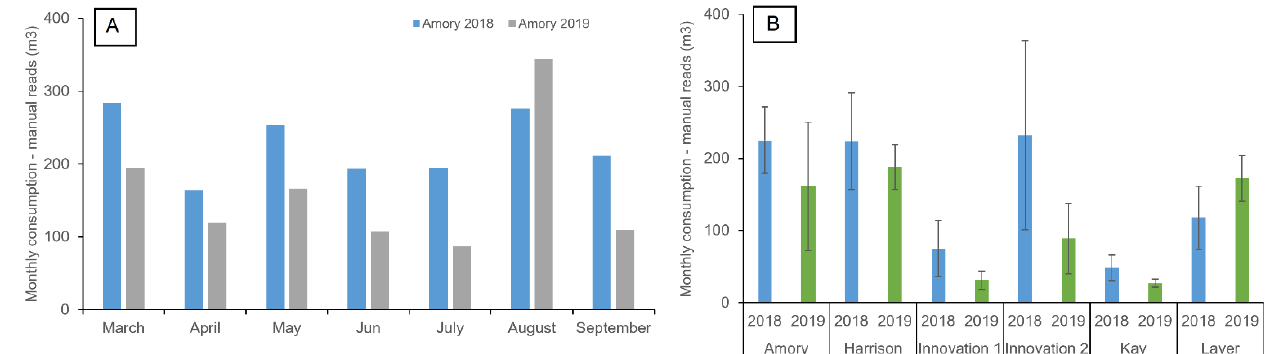
Figure 5. Comparison of estimated monthly consumption based on ( A ) manual monthly readings the Amory building between March–September 2018 (prior to ULFT installation; blue) and March–September 2019 (during this study; grey); and ( B ) mean meter readings for the aforementioned periods in 2018 (blue), 2019 (green) for each building.